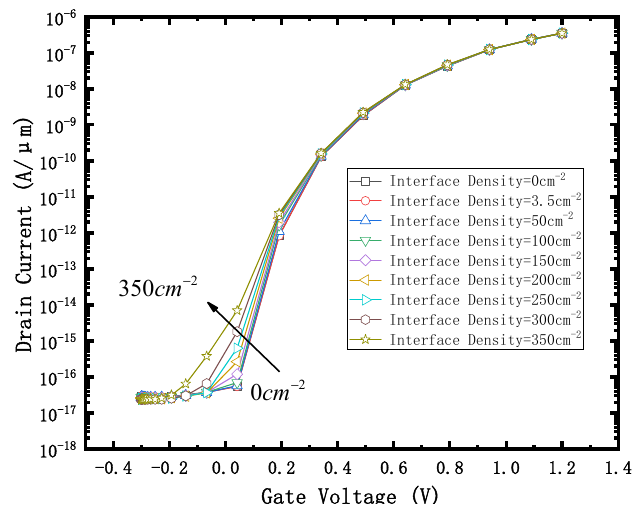
Figure 2. Id-Vg curve with different Interface Density. V drain = 0.8 V.